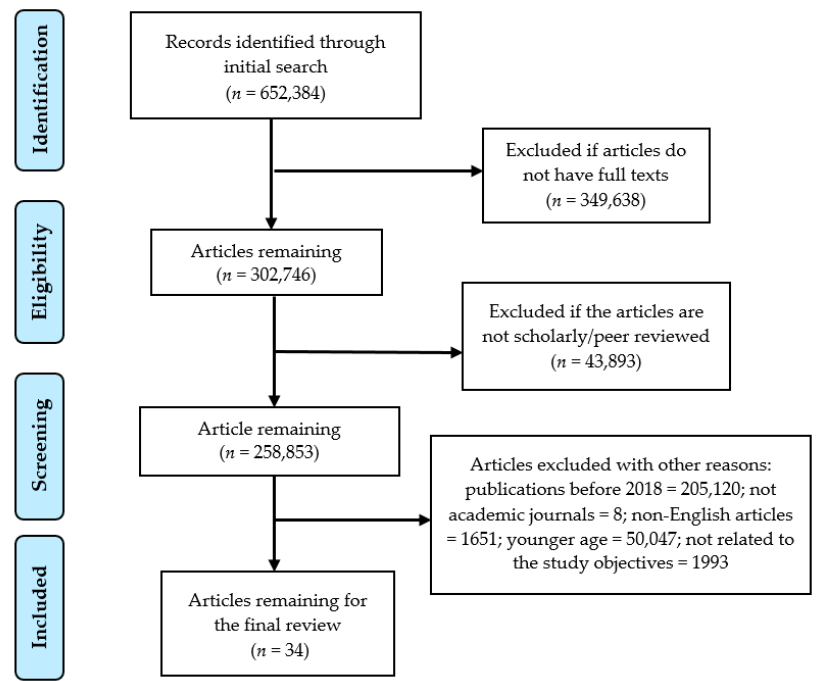
Figure 1. PRISMA flow chart to illustrate the article search and the inclusion process.